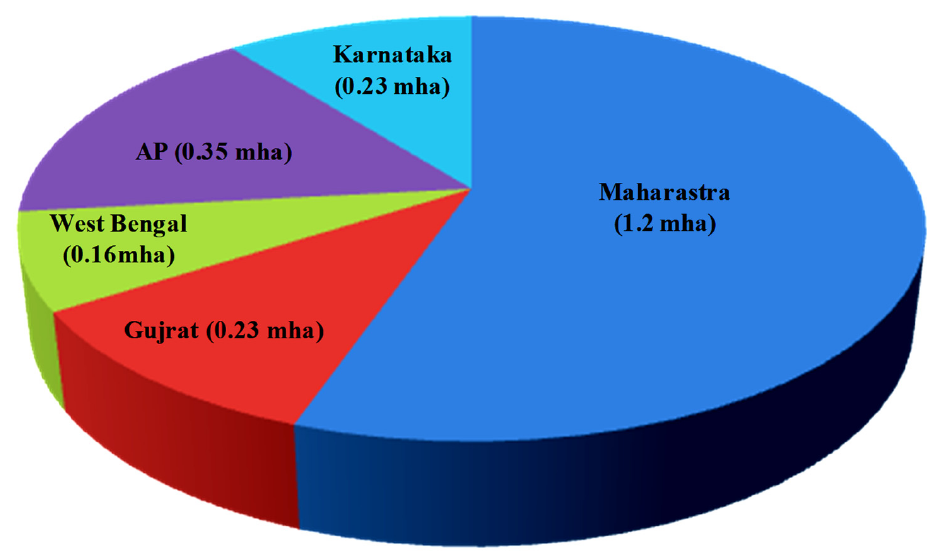
Figure 3. Distribution of Zeolitic Soil in India. Modified from Bhattacharyya et al. [40]. Structurally, zeolite is comprised of aluminosilicate (AlO 4 and SiO 4 ) tetrahedrons, joined into three-dimensional frameworks and seems like a honeycomb structure (Figure 4) [41]. The cages in the porous structure of zeolite are approximately 12 Å in diameter, interlinked through the channels of 8 Å diameter, includes 12 tetrahedrons rings [42]. Depending on the minerals, the pores are interlinked to form long wide channels which facilitate easy molecular movement into and out of the zeolite structure. The negative charge of aluminum ions in the zeolite structure is balanced by positively charged cations.